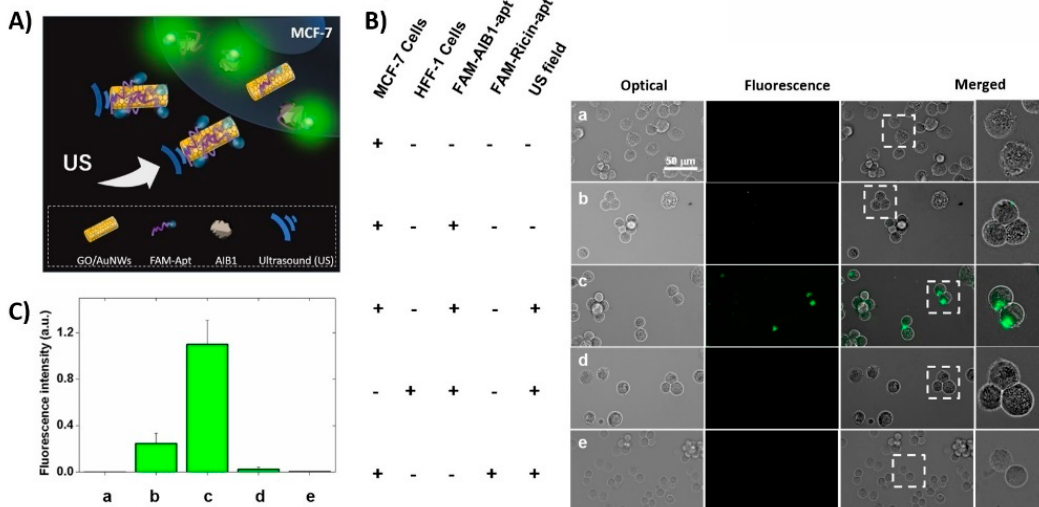
Figure 15. Intracellular fluorescent OFF-ON detection of AIB1 protein in MCF-7 breast cancer cells using US-propelled aptamer (FAM-AIB1-apt) functionalized nanomotors. ( A ) Schematic illustration of OFF-ON strategy based on fluorescence switching. Fluorescence of FAM-AIB1-apt is quenched due to adsorption at GO surface. Subsequently, the fluorescence signal is recovered in presence of specific target AIB 1. ( B ) Representative microscopic optical, fluorescence and merged images corresponding to cells treated under different conditions ( a – e rows). ( C ) Bar plot displaying the fluorescence intensity obtained under different treatments ( a – e ) describe in ( B ). Ultrasound field parameters: voltage amplitude 2 V, resonant frequency 2.66 MHz, and 15 min. Scale bar 50 μ m. Reproduced from [17] with permission of Wiley-VCH.